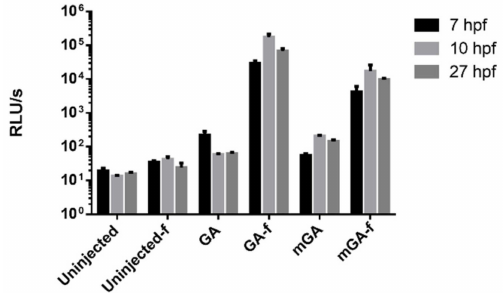
Figure 2. Aequorin reconstitution of GA and mitoGA (mGA) with f -coelenterazine assessed by luminometry in single embryos at 7, 10 and 27 hpf. Note the logarithmic scale. Shown as mean ± SEM ( n = 6 embryos for each condition). The reconstituted GA- f and mGA- f were statistically di ff erent from all controls according to a one-way ANOVA test. RLU, relative luminescence